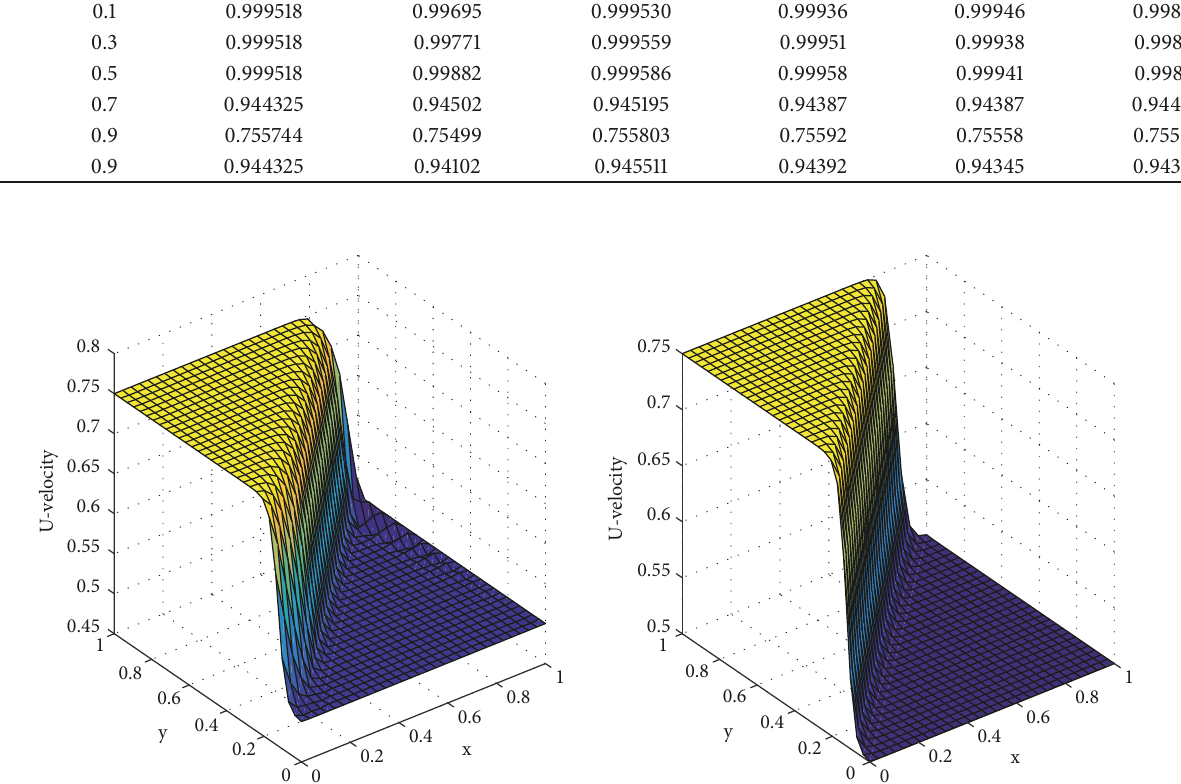
Figure 5: U-velocity profile produced by (left) the Hermite collocation scheme and (right) the exact, at Re = 500 with 𝑡 = 0.5,Δ𝑡 = 0.001 , and 𝑁 = 30 × 30 .